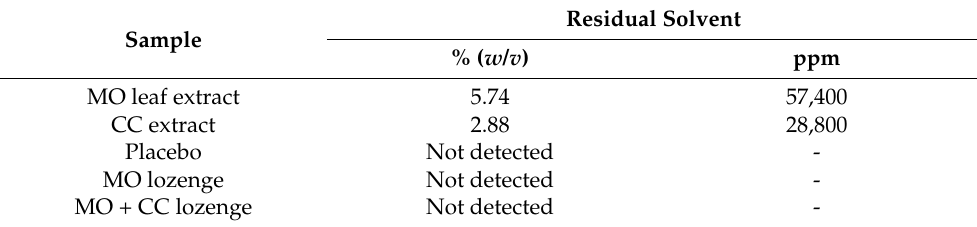
Table 1. Residual